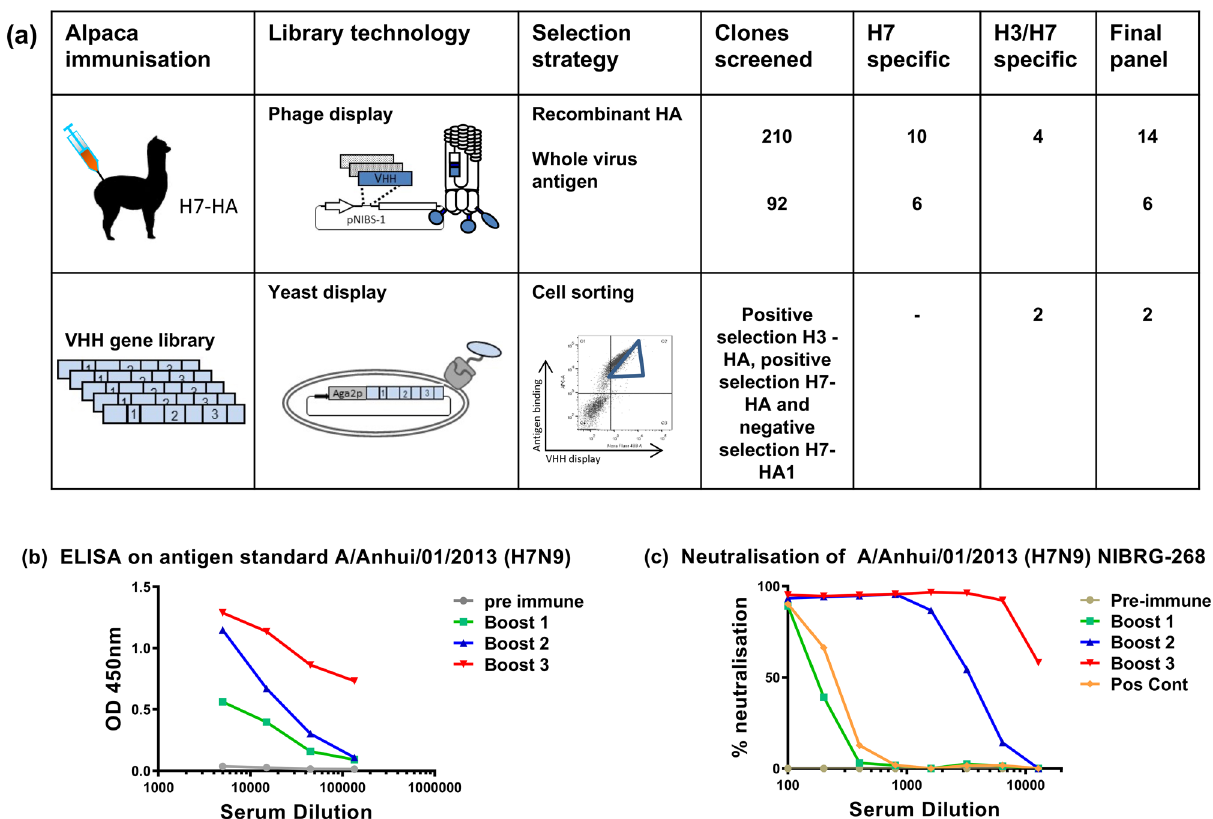
Figure 1. Isolation of H7-HA specific nanobodies. ( a ) The number of clones screened and the number of H7 or H3/H7 specific Nbs identified are shown from either phage display or yeast display library selection (Fig S1). ( b ) Serological immune response in immunised alpaca to A/Anhui/01/2013 (H7N9). Samples were taken pre-immunisation and after each of three boosts. ( c ) Serological neutralising immune response in immunised alpacas using micro-neutralisation assays of A/Anhui/01/2013 (H7N9) NIBRG-268. A positive control sheep serum specific for the reverse genetics virus was used as a positive